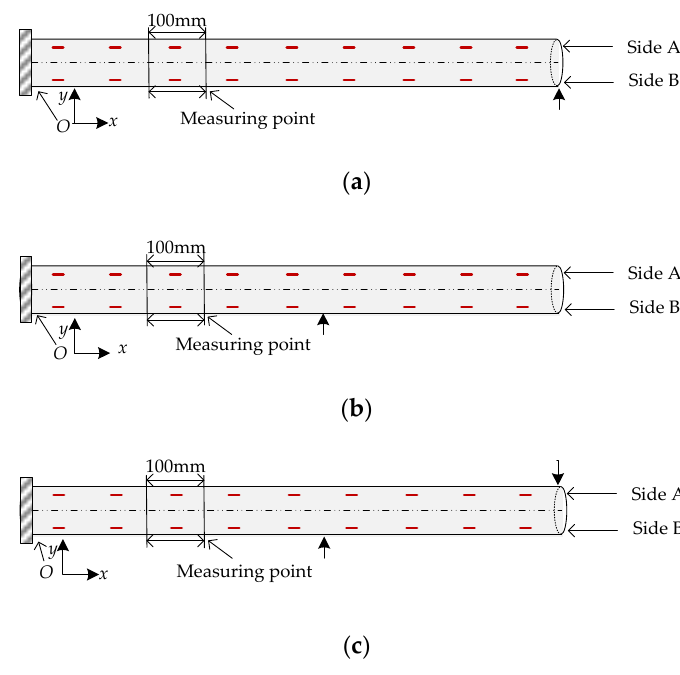
Figure 7. Schematic diagram of the bending shapes of the FBG implantable flexible morphological sensor under different loading modes. ( a ) Type 1: applying force at the end of the sensor. ( b ) Type 2: applying force at the middle of the sensor. ( c ) Type 3: applying force at two points of the sensor.